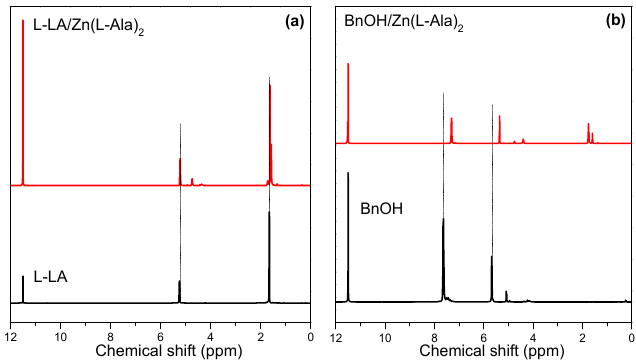
Figure 3. 1 H NMR spectra of ( a ) L -LA and L -LA + Zn( L -Ala) 2 (molar ratio 1:1) and ( b ) BnOH and BnOH + Zn( L -Ala) 2 (molar ratio 1:1) in d -trifluoroacetic acid.